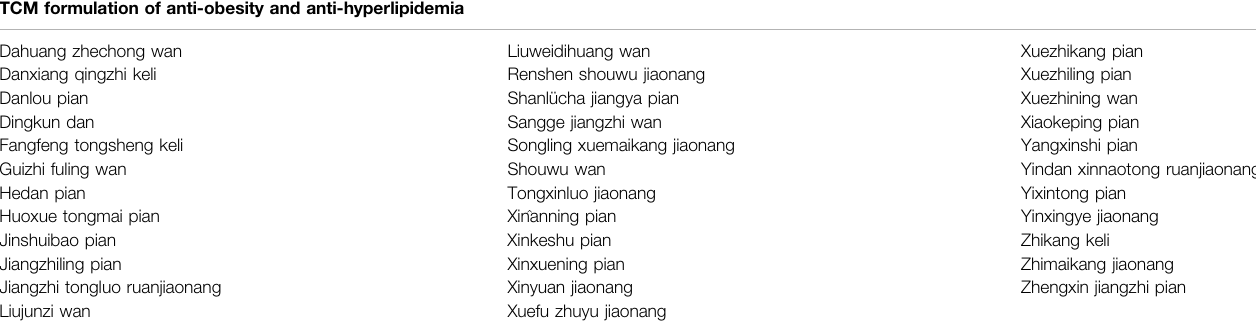
TABLE 1 | TCM anti-obesity formulations from the Pharmacopoeia of the People ’ s Republic of China (ChP) (2020 edition) . TCM formulation of anti-obesity and anti-hyperlipidemia